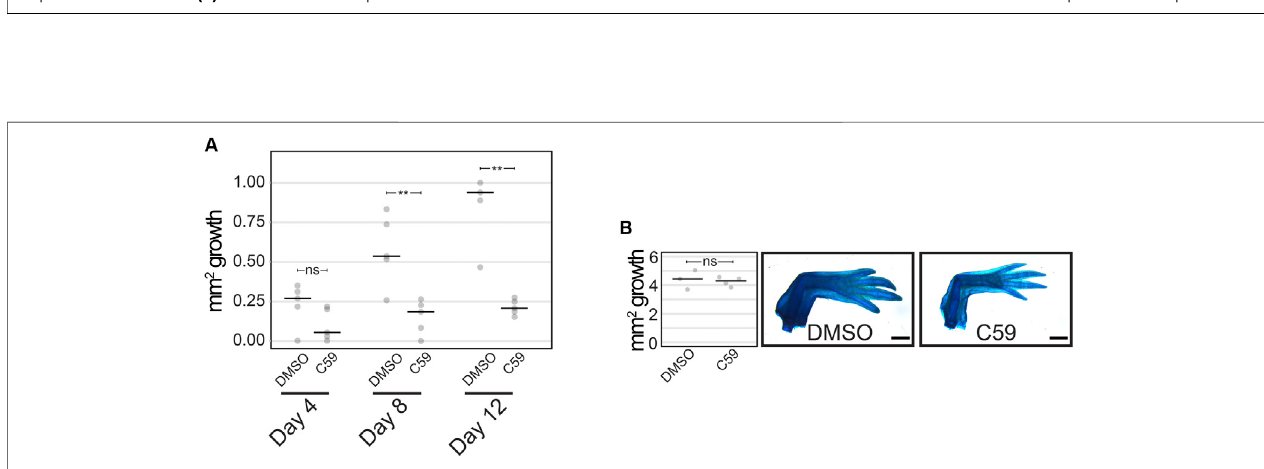
FIGURE 5 | Gene expression of limb patterning genes in stage 46 developing axolotl limb buds. (A) Expression of Frem3 in the distal epithelium. Some mesenchymalexpressioncanbeobservedintheanterior/proximalmesenchymehighlightedwithredarrowheads. (A 9 ) Epithelialexpressionof Frem3 decreasedandthe anterior mesenchymal expression wassigni fi cantly increased after C59treatmentshown by red arrowheads. (B) Epithelialexpression ofMtrans with ascewing towards the posterior side of the limb. (B 9 ) C59 treatment greatly decreased expression of Mtrans in the epithelium. (C) Bmp2 expression is expressed in the basal epithelium are indicated with orange arrowheads and mesenchymal expression is highlighted with red arrowheads. (C 9 ) Bmp2 expression had the same expression domains after C59 treatment, highlighted by orange arrowheads (epithelium) and red arrowheads (mesenchyme). The blue star indicates auto fl uorescence. (D) Bmp7 expression intheepitheliumindicatedwithorangearrowheadsand mesenchymal expressioninthedistal andanterior mesenchyme indicatedwithredarrowheads. (D 9 ) Bmp7 expression continued after C59 treatment withadecrease in theanteriormesenchyme. (E) Fgf10 expression throughout themesenchyme and lowerlevels in the epithelium. (E 9 ) Fgf10 expression was completely absent after C59 treatment. (F) Hand2 expression in the posterior limb mesenchyme. (F 9 ) Hand2 expression decreased and expanded in anterior regions of the mesenchyme, highlighted by red arrowheads. (G) Gli3 expression mainly in the mesenchyme. (G 9 ) Decreased Gli3 staining in the mesenchyme. Blue stars indicate non-speci fi c staining. (H) Broad mesenchymal staining of Etv4 throughout the limb bud with a few positive spots in the epithelium, highlighted by red arrowheads. (H 9 ) Decreased Etv4 expression after C59 treatment, but with the same expression pattern as (H) . (I) Distal mesenchymal expression of Hoxa13 . (I 9 ) Lack of Hoxa13 expression after C59 treatment. The blue star indicates auto fl uorscent muscle. Scale bars in all panels are 50 µm.